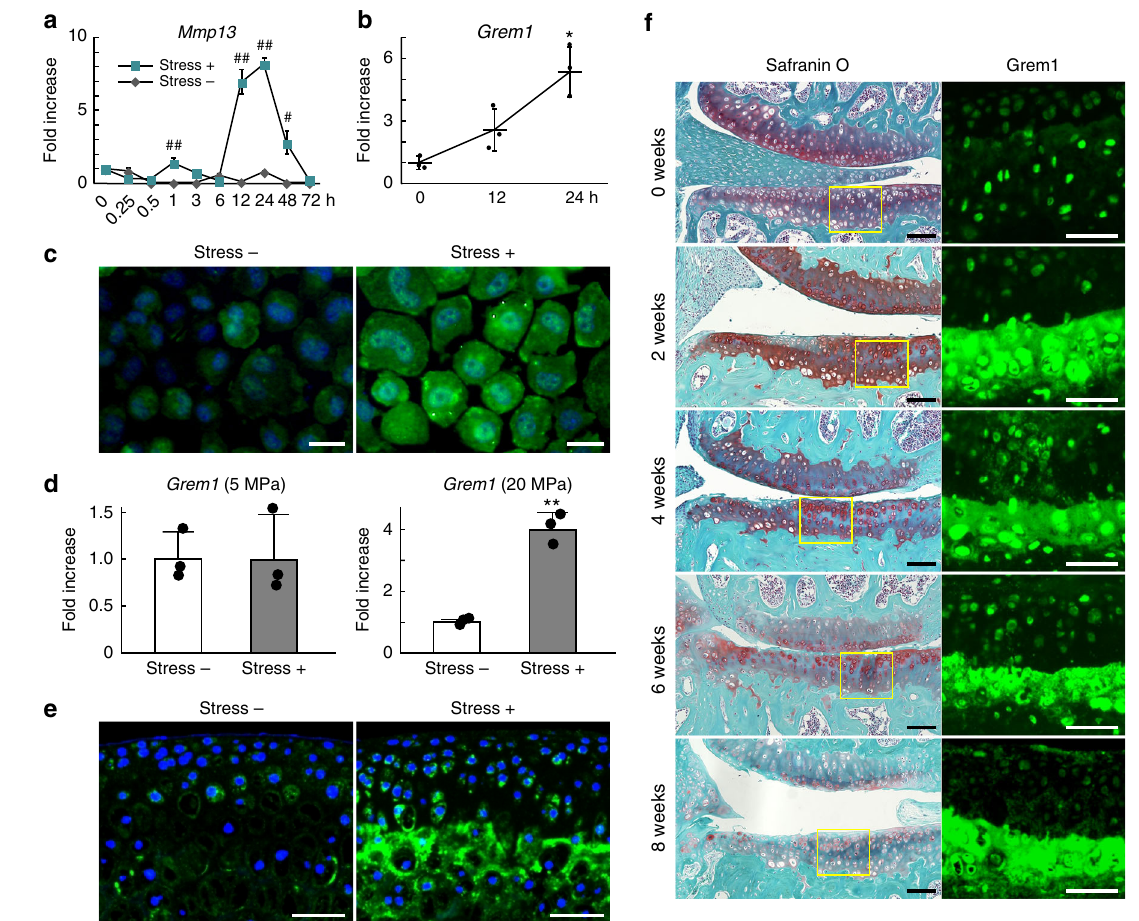
Fig. 1 Induction of gremlin-1 by excessive mechanical loading. a Time-course of Mmp13 mRNA levels in mouse primary chondrocytes after tensile stress loading (stress + ), or without loading (stress − ). Cells were cultured up to 72 h after uniaxial cyclic tensile strain (10%, 0.5 Hz, 30 min). # P < 0.005, ## P < 0.001 versus stress — at each time-point (two-way ANOVA test). b Gremlin-1 mRNA levels in mouse primary chondrocytes after tensile stress loading. * P < 0.05 versus 0 h (one-way ANOVA test). c Gremlin-1 protein expression in mouse primary chondrocytes 24 h after tensile stress loading (stress + ), or without loading (stress − ). Nuclei were stained with DAPI (blue). Scale bars, 50 µ m. d Gremlin-1 mRNA levels in mouse femoral head cartilage after hydrostatic pressure loading (5 or 20 MPa, 0.1 Hz, 30 min). # P < 0.005 versus stress − (Student ’ s unpaired two-tailed t -test). e Gremlin-1 immuno fl uorescence in mouse femoral head cartilage after 20 MPa hydrostatic pressure loading. Nuclei were stained with DAPI (blue). Scale bars, 100 µ m. f Safranin O staining and gremlin-1 immuno fl uorescence during the time-course of mouse osteoarthritis development after surgical induction. Inset boxes in safranin O staining indicate regions of immuno fl uorescence. Scale bars, 100 µ m and 50 µ m, respectively. All data are expressed as mean ± SD